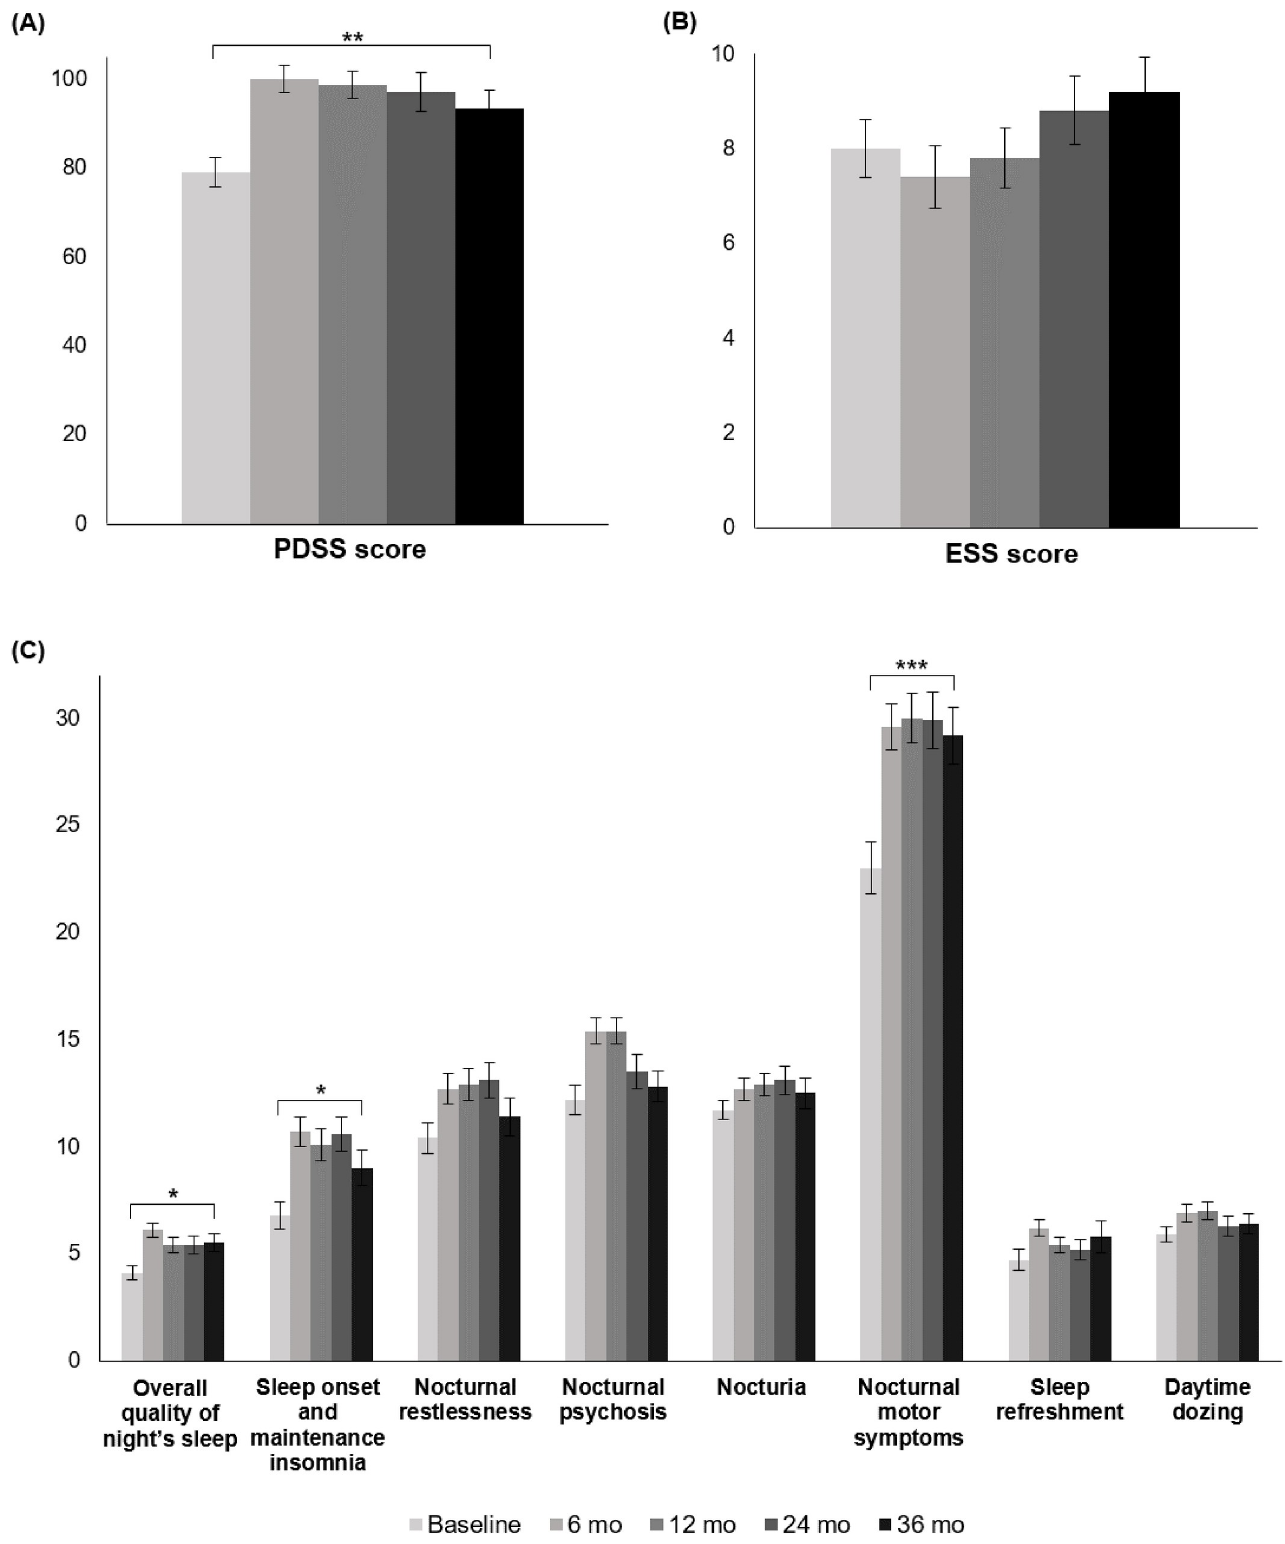
Fig 1. 3-year follow-up changes in the PDSS and ESS scores of PD patients with STN DBS. (A) Mean PDSS total score over time. (B) Mean ESS total score over time. (C) Mean scores over time for the eight PDSS domains. � p values < 0.05, �� < 0.01, and ��� < 0.001 by linear mixed model.